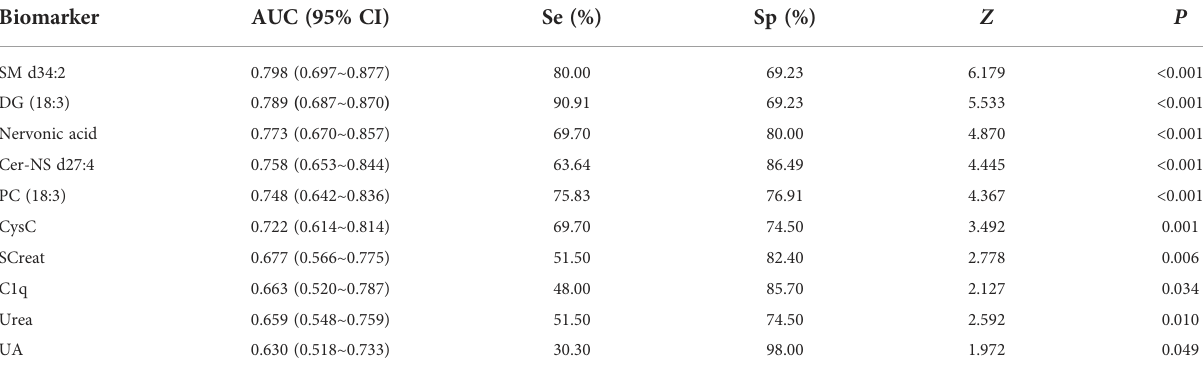
TABLE 4 Diagnostic ef fi ciency of fi ve selected metabolites for discriminating LN from SLE. Biomarker AUC (95% CI) Se